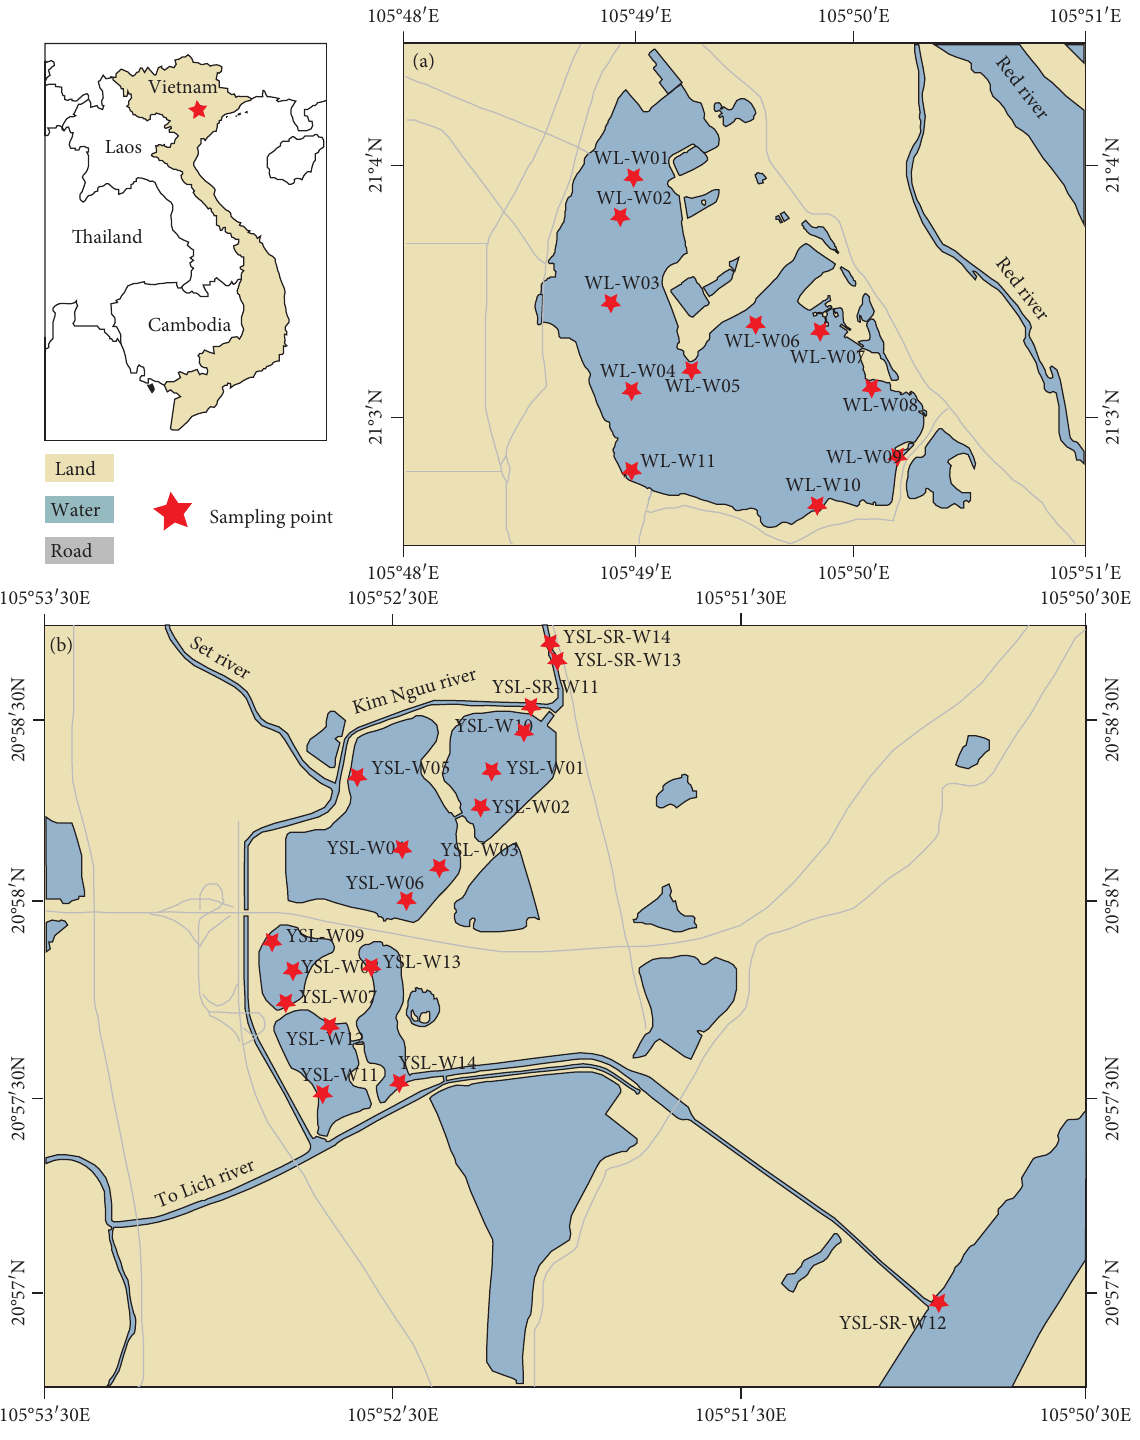
Figure 1: Sampling sites for urban lakes. Sampling points WL-W01 to WL-W11 are located in West Lake (a). YSL-W01 to YSL-W14 are situated in Yen So Lake